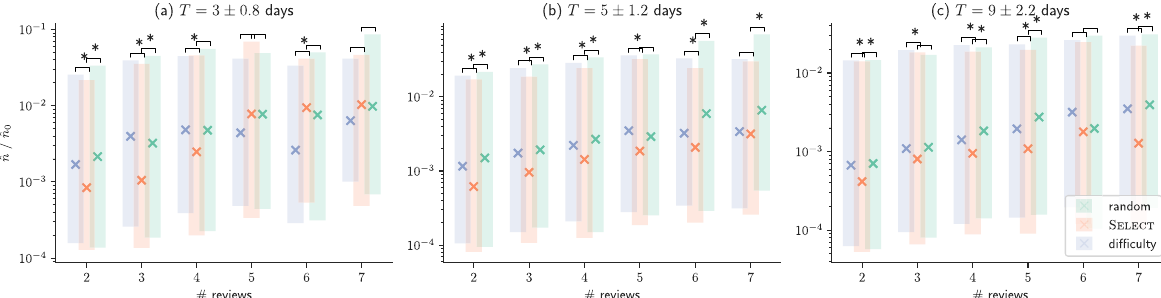
Fig. 1 Normalized empirical forgetting rate. (Lower is better). Each triplet of bars in the fi gures corresponds to (learner, question) pairs in which the learner reviewed the question the same number of times (# reviews) for approximately the same period of time (T). Boxes indicate 25% and 75% quantiles and crosses indicate median values, where lower values indicate better performance. For each triple of bars, asterisk indicates a statistically signi fi cant difference (Matt – Whitney U-test, two-sided; p value = 0.05/36, Bonferroni correction).